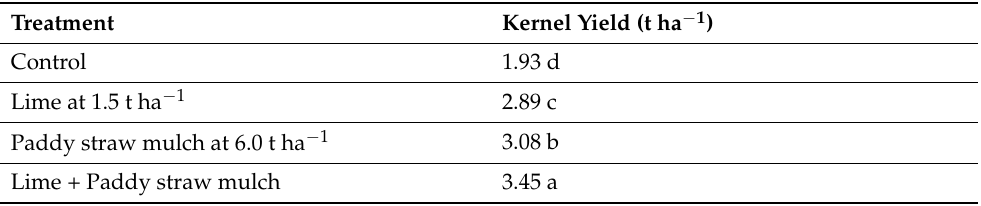
Table 9. Increase in soil pH and yield of crops in acid sulphate soils of the Ganges Delta through integrated management (green manuring, liming, and phosphorus application). Treatments